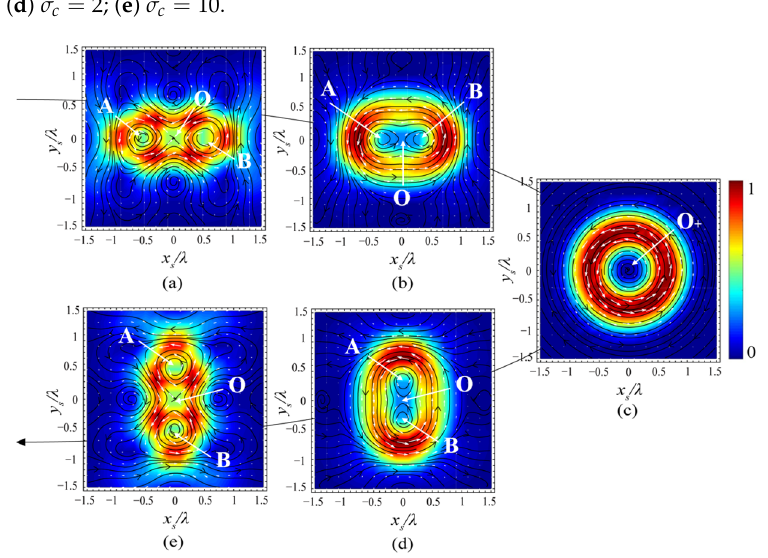
Figure 14. The transverse energy flow on the focal plane for 𝑙 = 2 : ( a ) 𝜎 (cid:3030) = 0.1 ; ( b ) 𝜎 (cid:3030) = 0.5 ; ( c ) 𝜎 (cid:3030) = 1 ; ( d ) 𝜎 (cid:3030) = 2 ; ( e ) 𝜎 (cid:3030) = 10 .